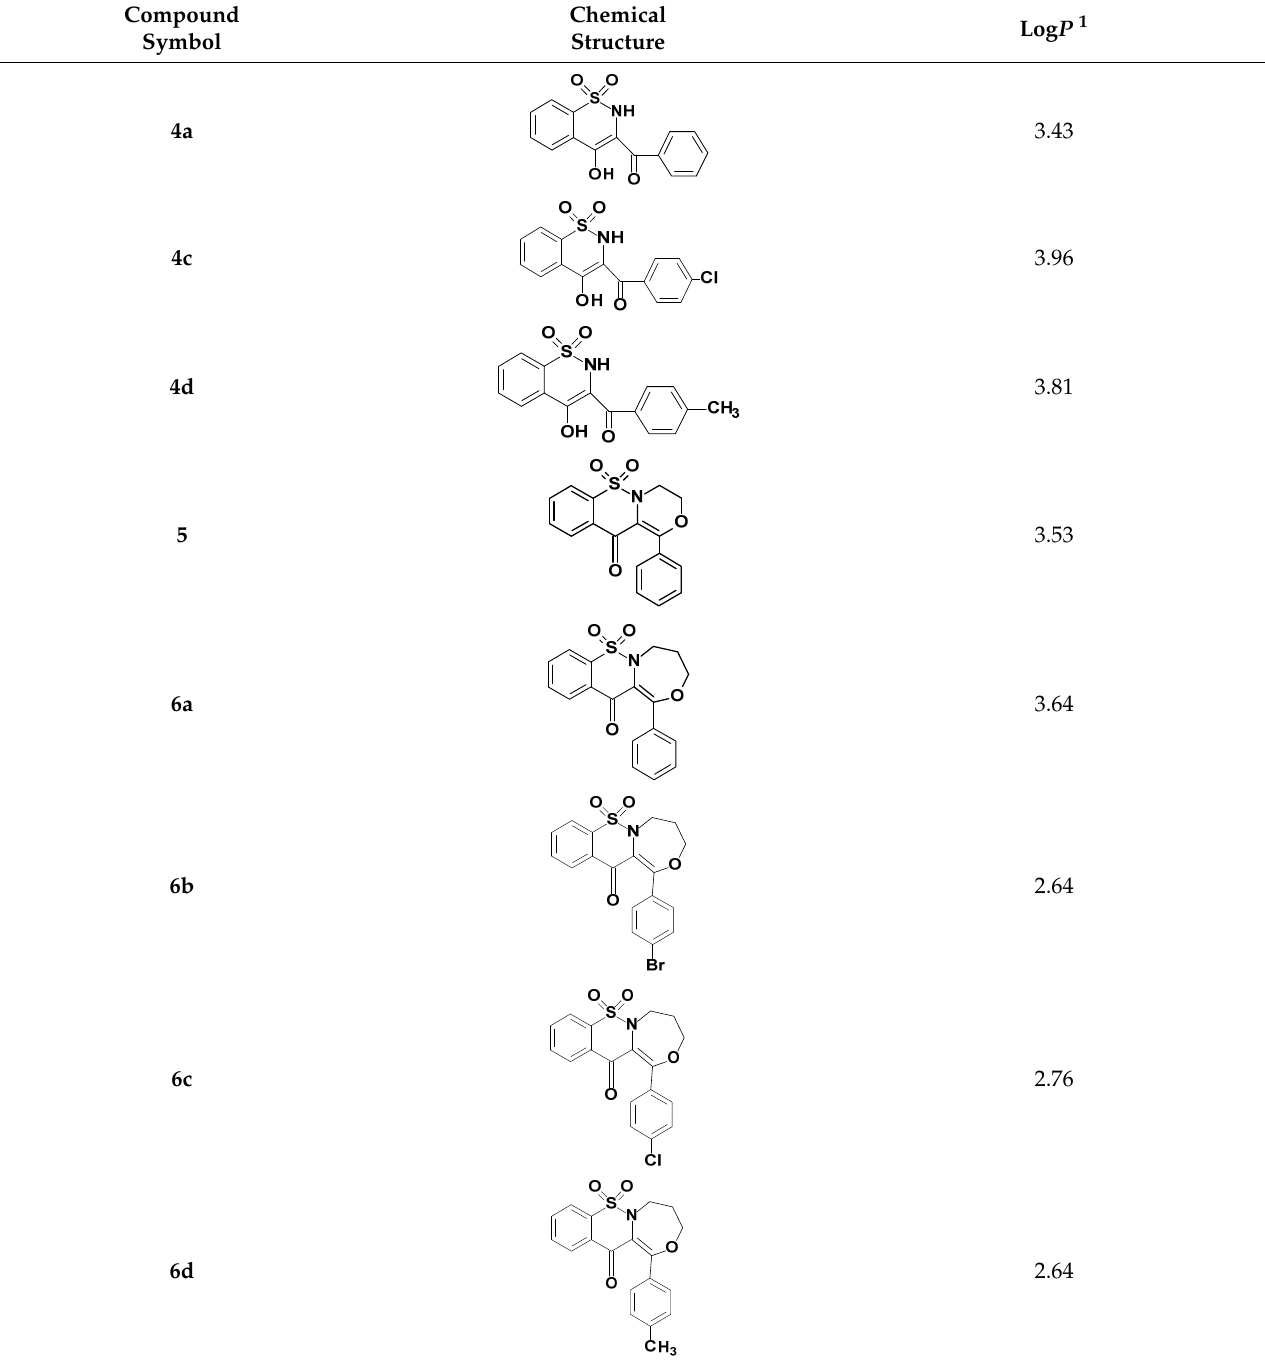
Table 1. Chemical structure and symbols of new tricyclic 1,2-thiazine derivatives with Log P values. Compound Symbol